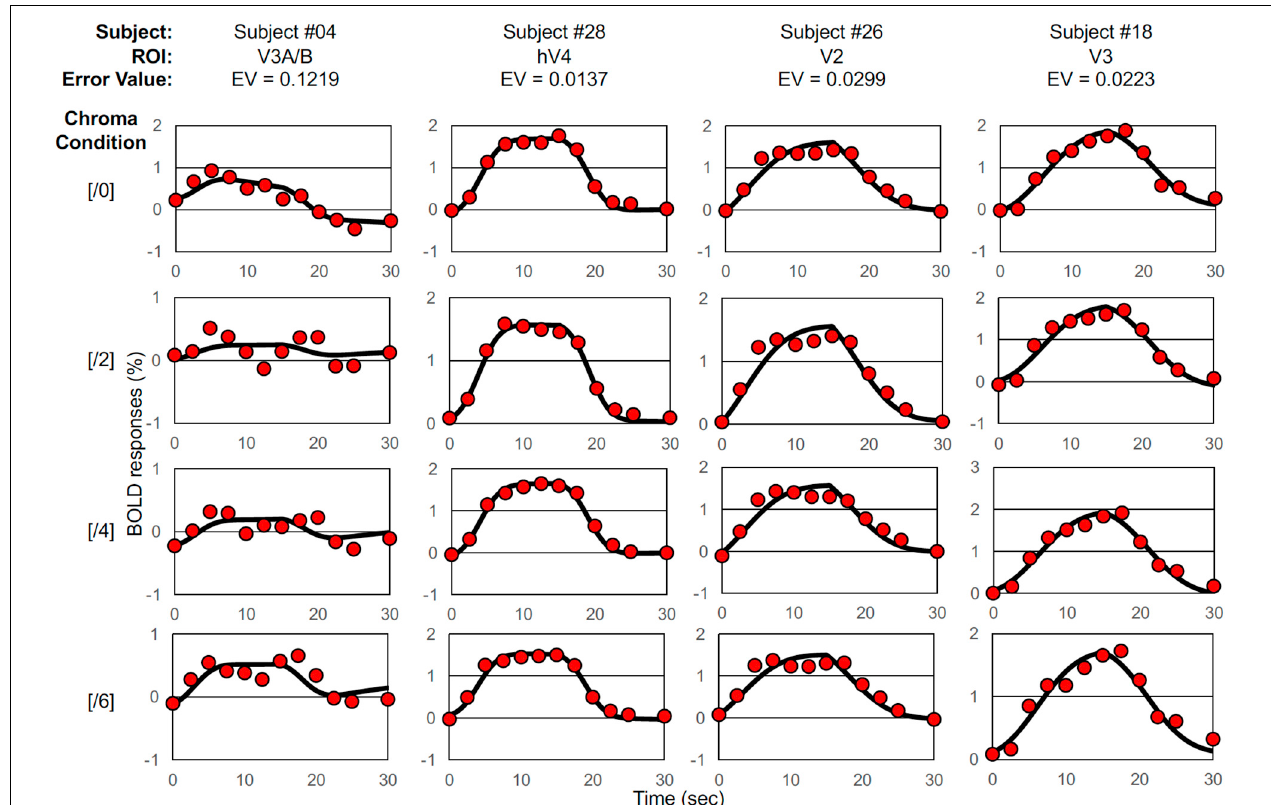
FIGURE 2 | Examples of BOLD signal data and model fits. Selected BOLD signal data (denoted by red circles) and model fittings generated by the two-Gaussian pulse model (Eq. 1, solid curves) under Chroma conditions from /0 (top raw) to /6 (bottom raw), the worst-case fitting (EV = 0.1219) (first column), the best-case fitting (EV = 0.0137) (second column), the case of fitting where EV was around the average (EV = 0.0299) (third column), and the case of fitting where EV was the median (EV = 0.0223) (forth column).